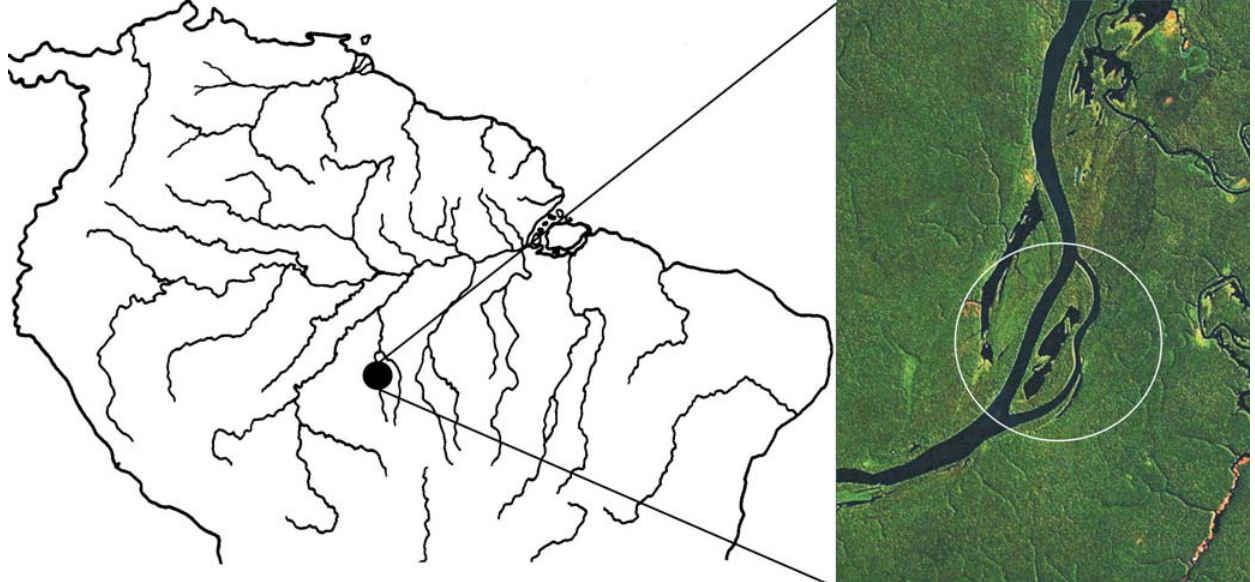
Fig. 3. Partial map of South America showing the type locality of Gladioglanis anacanthus . White circle showing the Mamão lake inside the Mamão Island, in the middle part of rio